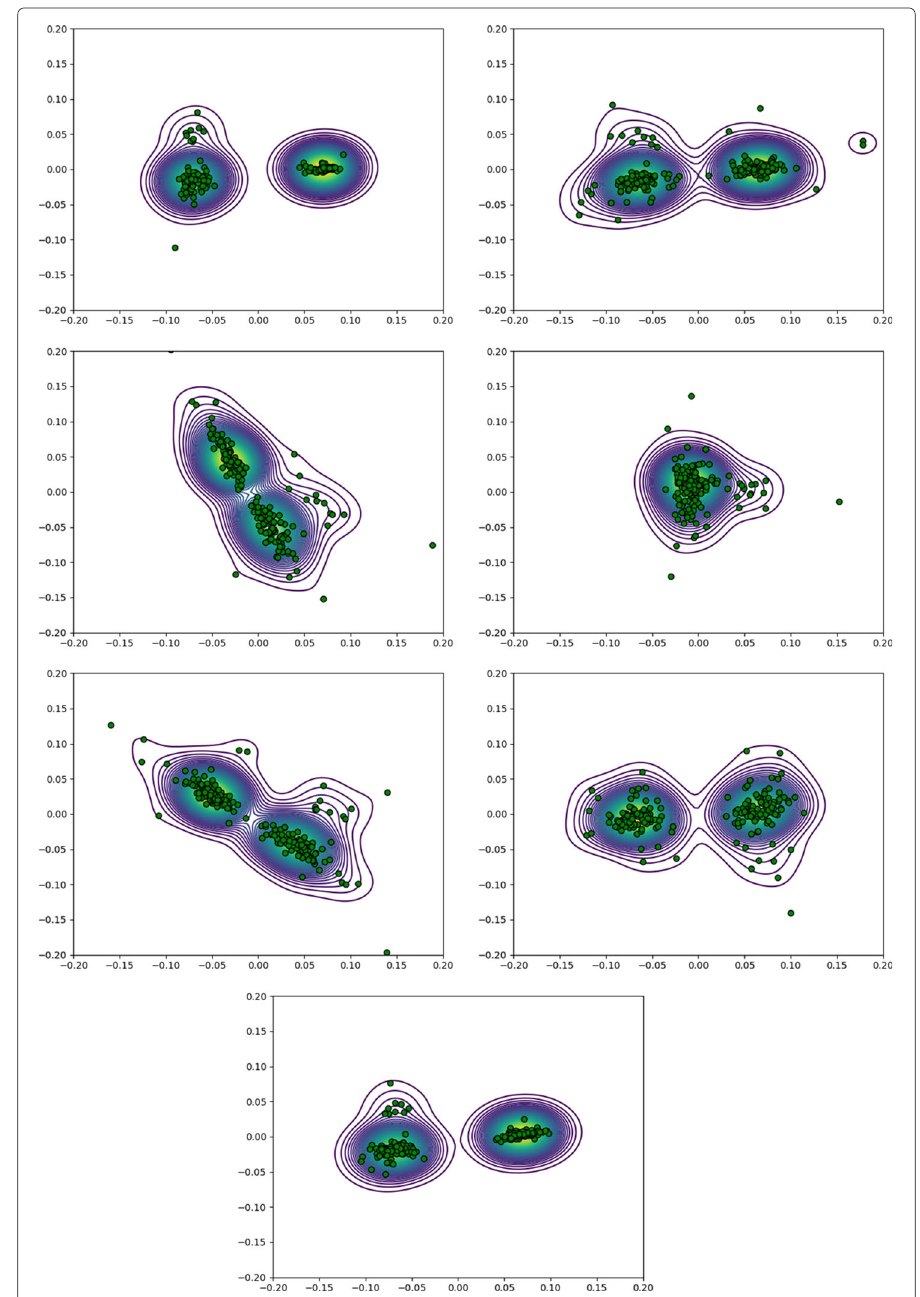
Fig. 2 Synthetic graph spectral plots, frames 1-7. The spectral plots of the synthetic data snapshots are presented in order from left to right, and top to bottom. They show two communities that are stable and separate except for the merger shown in the fourth frame. There are also nodes that do not associate closely with any community at various points in time